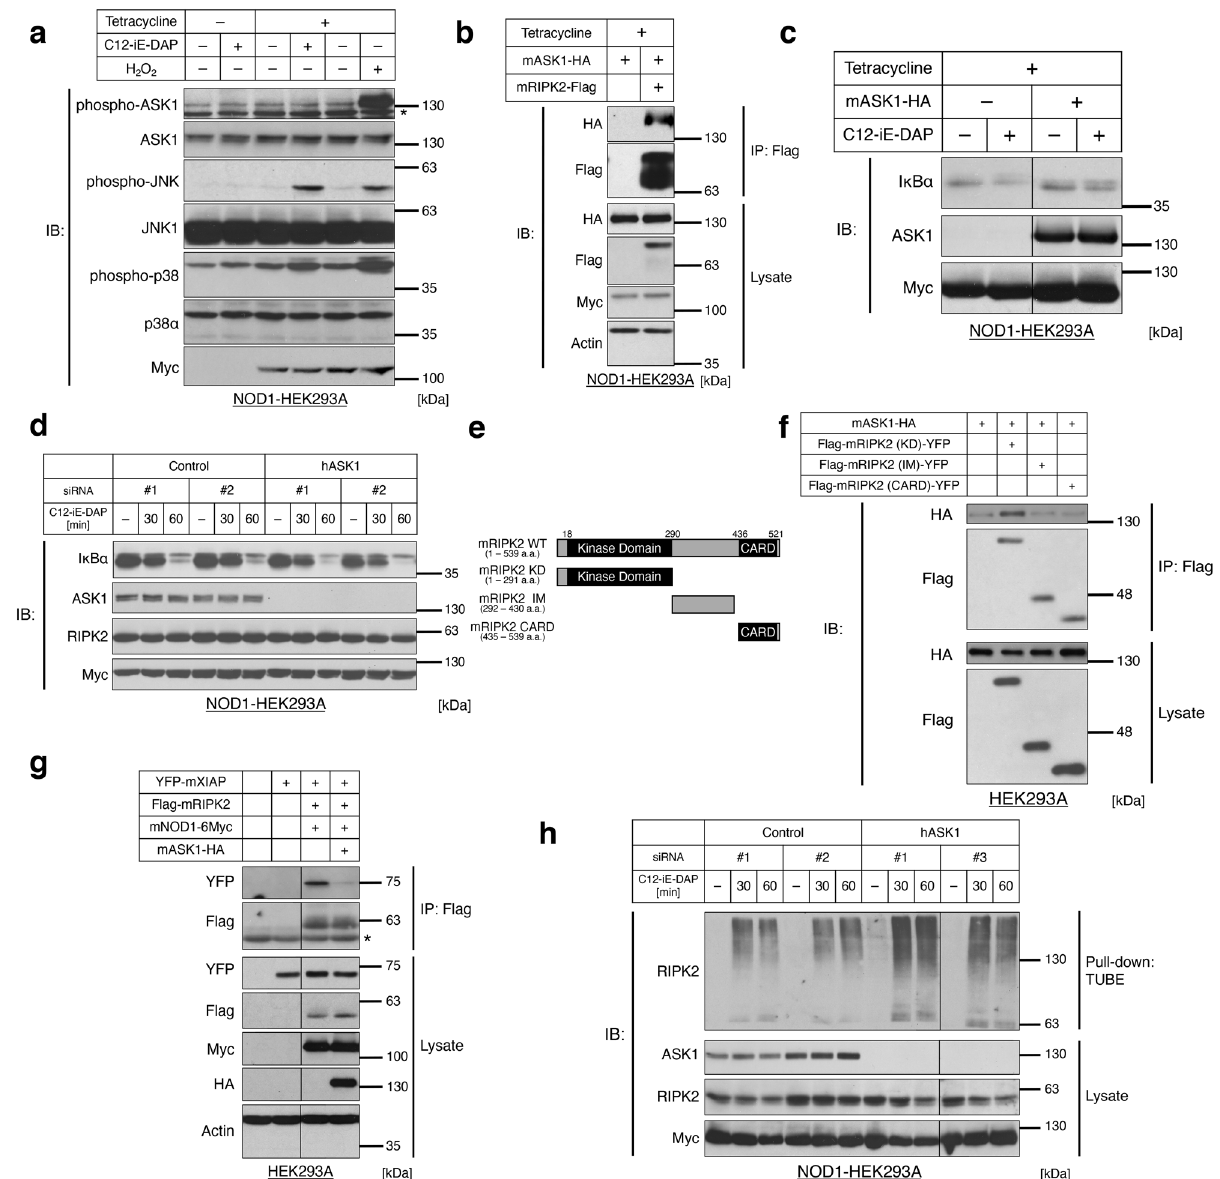
Figure 2. ASK1 inhibits the activation of the RIPK2 signaling complex. ( a ) Phosphorylation levels of ASK1 under NOD1 ligand treatment in NOD1-6Myc-stably expressing HEK293A cells (NOD1-HEK293A cells). NOD1-HEK293A cells were stimulated with a NOD1 ligand C12-iE-DAP (1 µg/mL, 30 min). mNOD1 mouse NOD1, H 2 O 2 a positive control of ASK1 phosphorylation, 250 µM, 30 min. *Nonspecific bands. ( b ) Interaction between RIPK2 and ASK1 in NOD1-HEK293A cells. After the induction of NOD1 with tetracycline, the co-transfected NOD1-HEK293A cells were processed for immunoprecipitation by anti-Flag-tag antibody beads. mASK1 mouse ASK1, mRIPK2 mouse RIPK2. ( c,d ) Effects of ASK1 overexpression ( c ) or ASK1 knockdown ( d ) on NOD-RIPK2 pathway activation. ASK1-overexpressing ( c ) or ASK1-knockdown ( d ) NOD1-HEK293A cells were stimulated with C12-iE-DAP (1 µg/ mL) for 60 min or the indicated periods of time, respectively. Note that cycloheximide (50 µg/mL) was treated to prevent the rapid feedback synthesis of IκBα. hASK1 human ASK1. ( e ) Schematic representation of RIPK2 deletion mutants. The numbers indicate the amino acid (a.a.) positions in wild-type (WT). Black rectangles indicate registered domains in the Pfam database (P58801). KD kinase domain, IM intermediate domain, CARD caspase-recruitment domain. ( f ) Binding ability of RIPK2 domain mutants to ASK1. Co-transfected HEK293A cells were processed for immunoprecipitation by anti-Flag-tag antibody beads. ( g ) Effects of ASK1 overexpression on the RIPK2-XIAP interaction. Co-transfected HEK293A cells were processed for immunoprecipitation by anti-Flag-tag antibody beads. mXIAP mouse XIAP. *Immunoglobulin G heavy chain. ( h ) Effects of ASK1 knockdown on K63-polyubiquitination of endogenous RIPK2 under NOD1 ligand stimulation. ASK1-knockdown NOD1-HEK293A cells were stimulated with C12-iE-DAP (1 µg/mL) for the indicated times, from which lysate K63-polyubiquitinated conjugates were purified with a tandem ubiquitin binding entity (TUBE) pull-down assay. Note that superfluous lanes were digitally eliminated from blot images in ( c,g,h ) as indicated by black lines and the uncropped images are presented in Supplementary